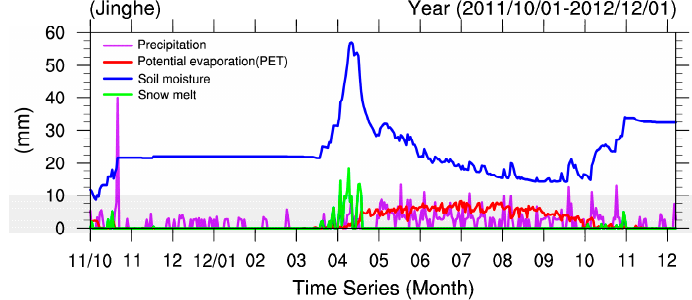
Figure 11. Spatial distribution of soil moisture and snowmelt rateof the JBR.